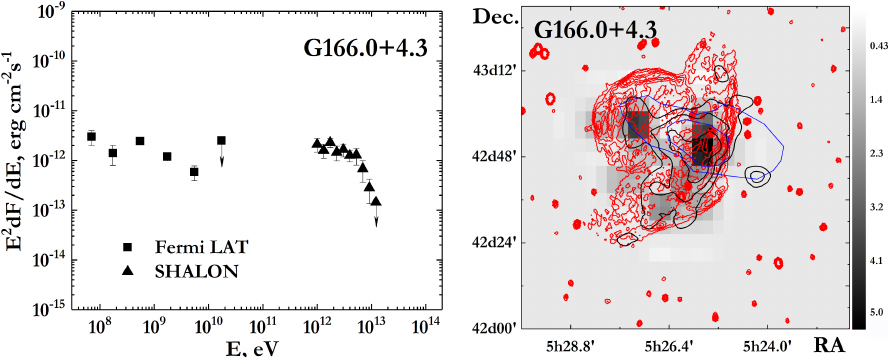
Figure 5. ( left ): Spectral energy distribution of G166.0+4.3 SNRs: (cid:78) at TeV energies show the data from SHALON observations. ( right ): Emission map of SNR by SHALON (grey scale). Red lines show Canadian Galactic Plane Survey DRAO data; black contours are the X-ray data by ROSAT, and blue lines show MeV-GeV emission regions by Fermi LAT (see text for the